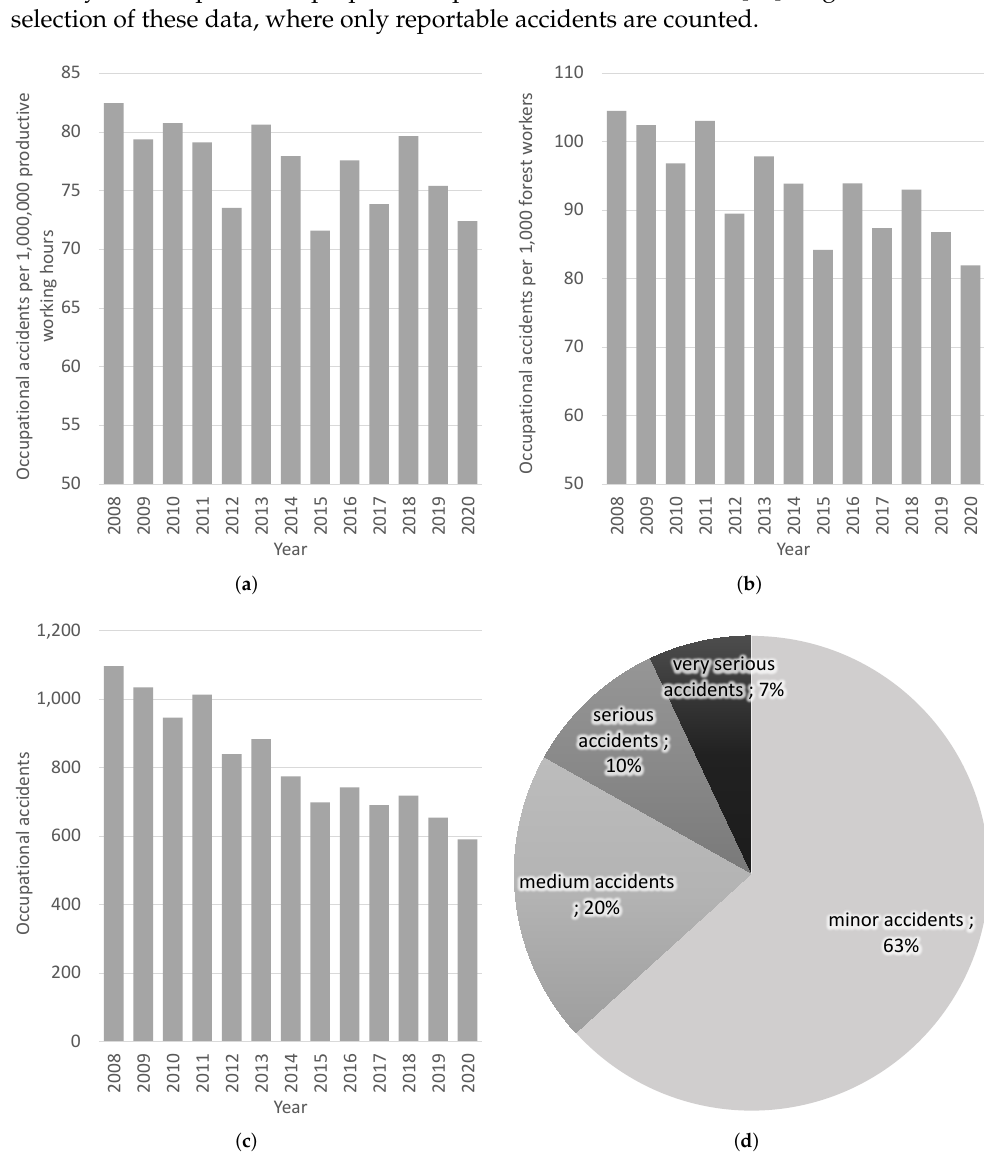
Figure 1. Forest occupational accidents in German state forests from 2008 to 2020: ( a ) occupational accidents per 1,000,000 productive working hours; ( b ) occupational accidents per 1000 forest workers; ( c ) occupational accidents; and ( d ) severity of accidents at work in days of lost service: minor accidents (4–20 days lost), medium accidents (21–45 days lost), severe accidents (46–90 days lost) and very severe accidents (more than 90 days lost; data source: